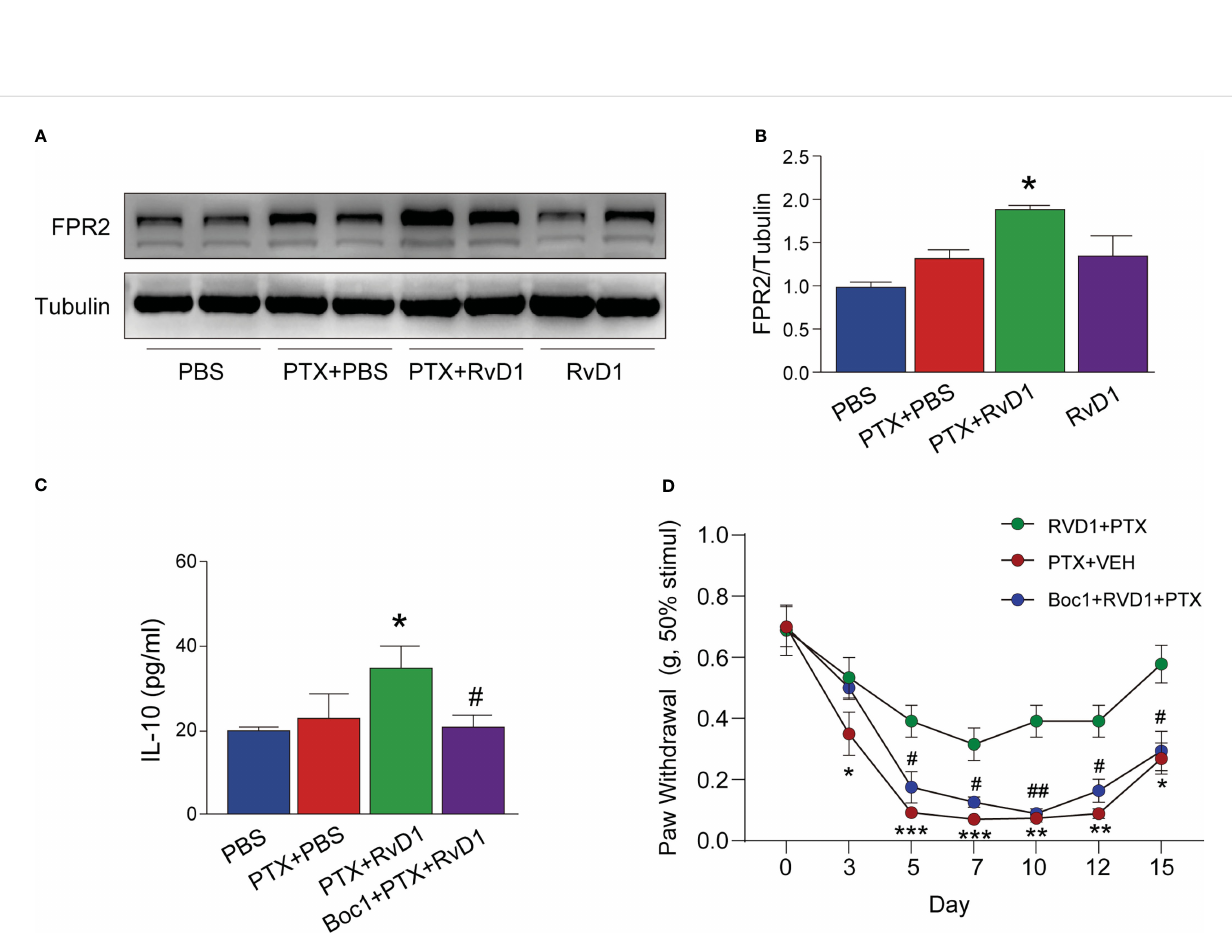
FIGURE 7 RvD1 promoted the production of IL-10 and its analgesic effect on PINP by activating FPR2 receptor. BMDMs were treated with FPR2 receptor blocker BOC1 (1 m M) for 3 h, RvD1 (250 nm) for another 3 h, and then treated with PTX (1 m M)for 24h. The expression of FPR2 in BMDMs was detected using Western blot (A, B) . The IL-10 protein in BMDMs supernatant was detected by ELISA (C) . Mechanical pain threshold was determined using von Frey test (D) . Boc1 (5 mg/kg/day) was administered intraperitoneally. *p < 0.05, **p < 0.01, ***p < 0.001 vs PTX group; #p<0.05, ##p<0.01 vs RvD1+PTX group. n=4 (A – C) , n=8 (D) . RvD1, resolvin D1; PTX,